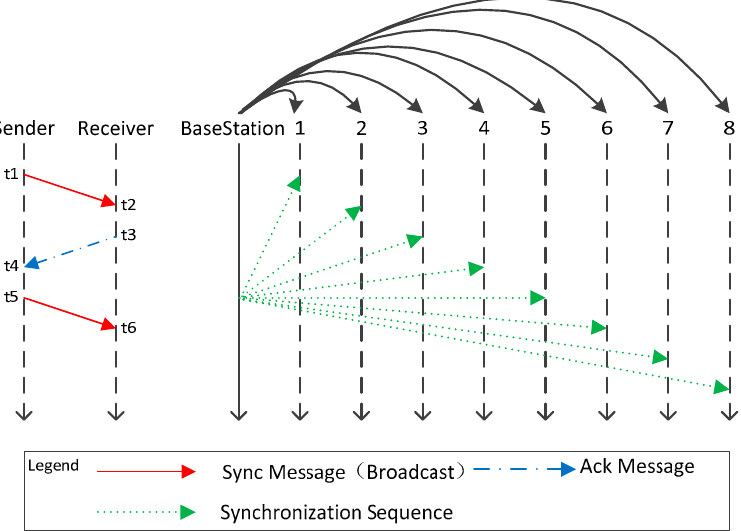
Figure 6. Synchronization schematic of the base-station to sensor.